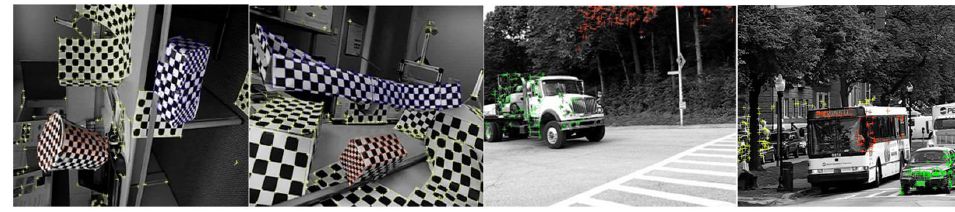
Figure 1. Samples from the Hopkins 155 dataset. The ORL dataset, which was created by Cambridge University, contains 400 facial photos of 40 subjects with a dark uniform background under different conditions for time, light and facial expression. We resized each photo to 32 × 32. Some samples from the ORL dataset are shown in Figure 2.